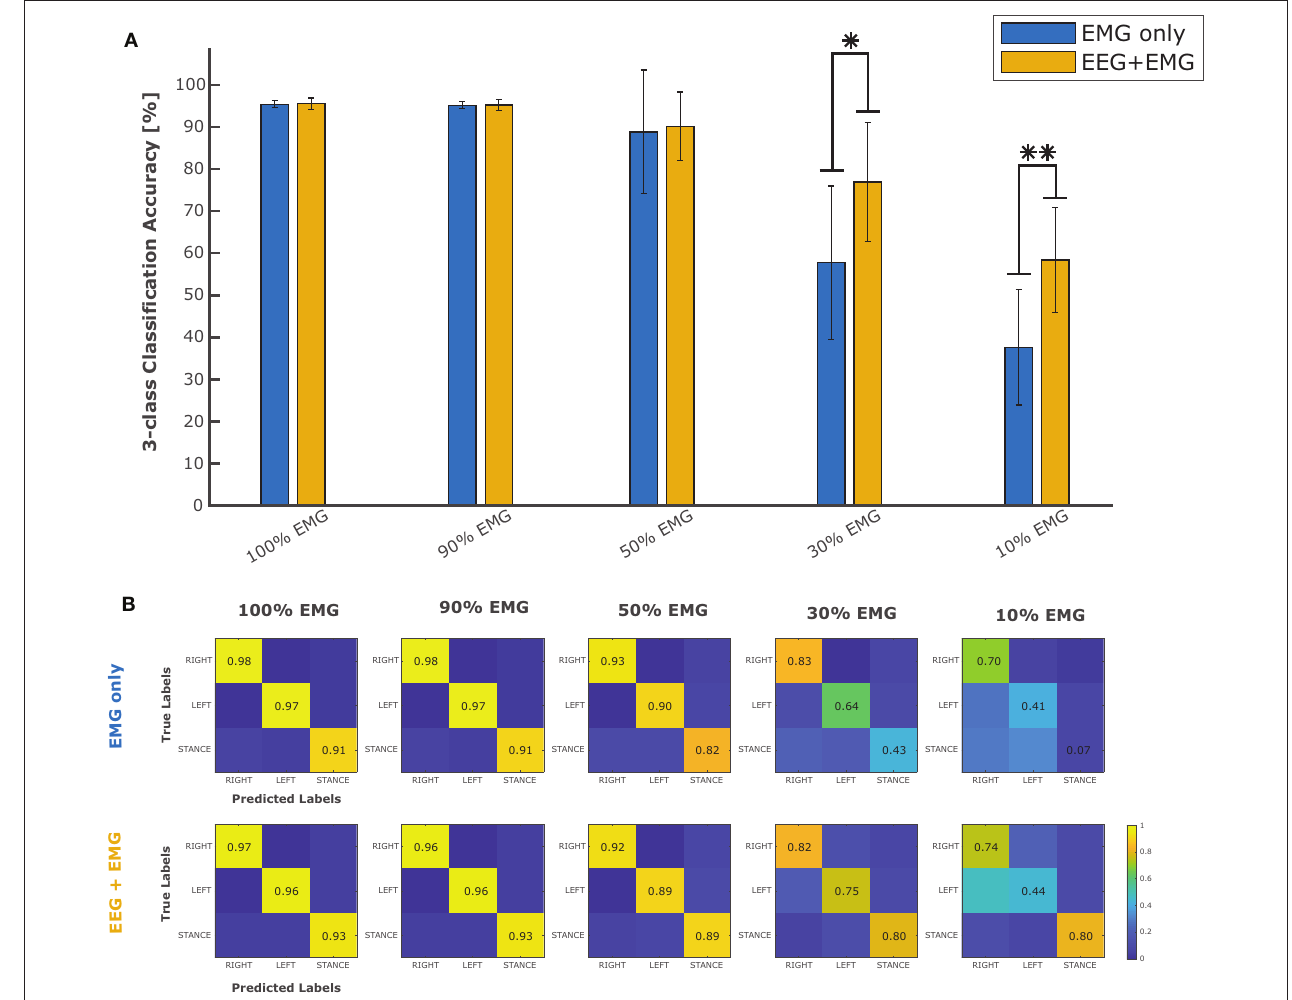
FIGURE 5 | (A) Average classification accuracy in five different conditions (100, 90, 50, 30, and 10% of EMG signal amplitude) using only the EMG signals (blue bars) to classify between right swing, left swing and stance phases, with respect to the performance achieved by the use of EEG and EMG signals together (yellow bars). (B) Confusion matrices obtained on the test set by the classifier using only the EMG signals and the hybrid (EEG + EMG) approach at different levels of EMG amplitude. ∗ p < 0.05; ∗∗ p <